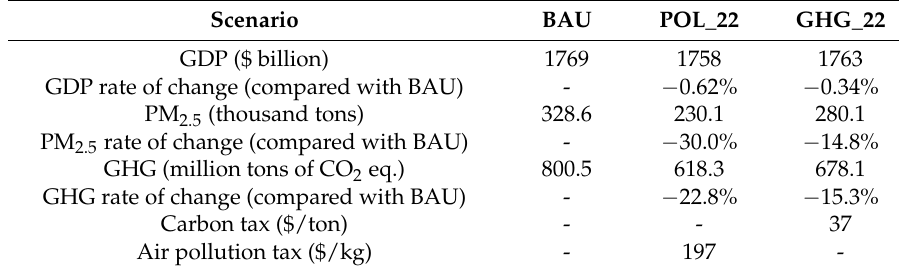
Table 7. Impact on gross domestic product (GDP) and